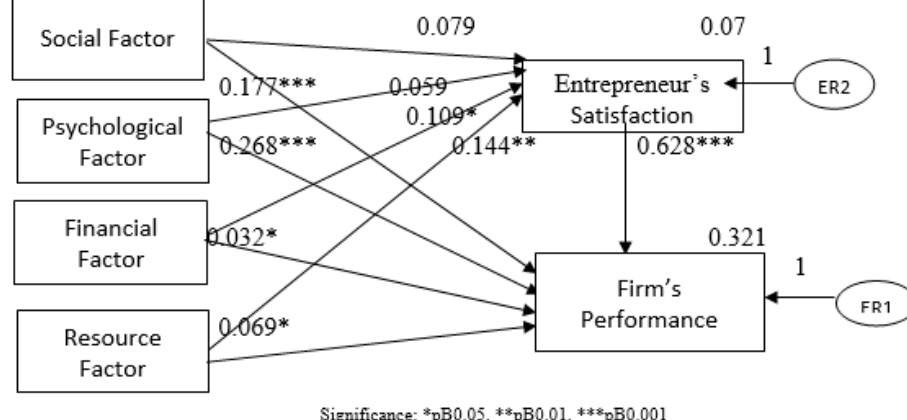
Figure 1. Research model with measured values.